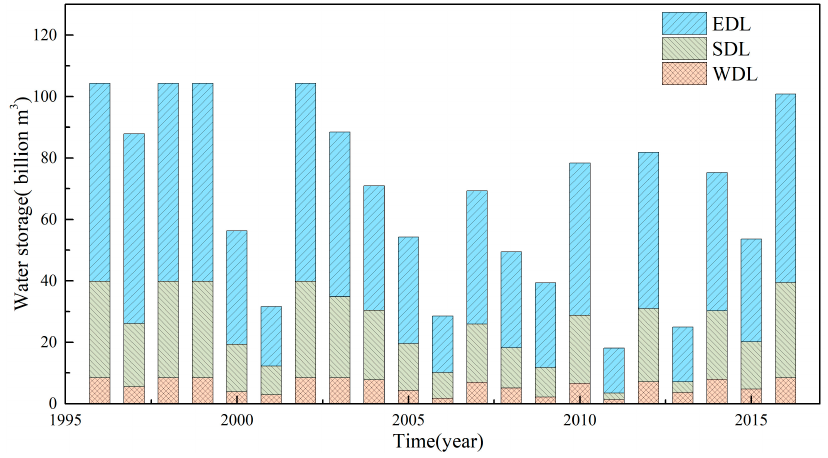
Figure 8. The usable water storage capacity in Dongting Lake in each year (1996–2016).